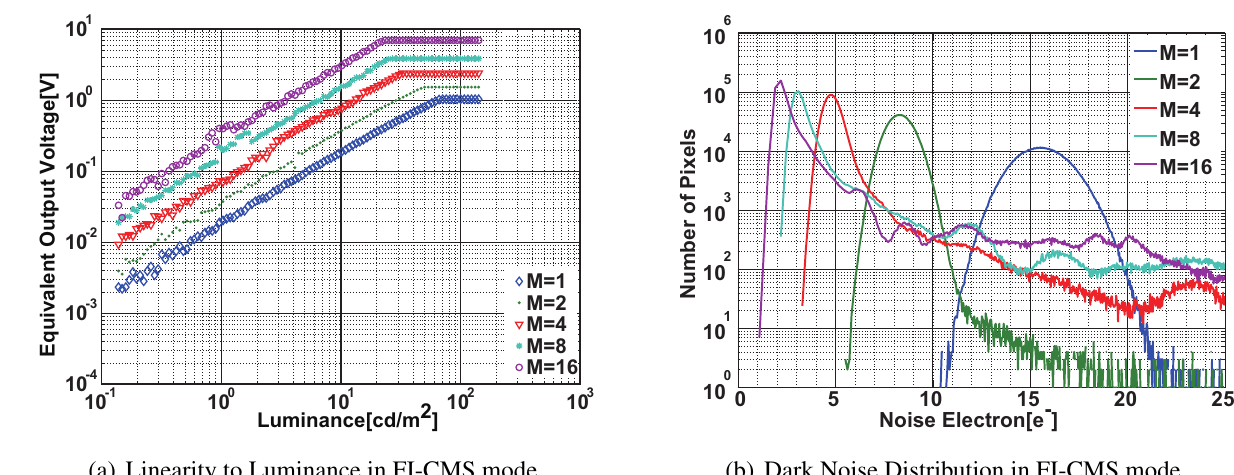
Figure 13. Characteristics in FI-CMS